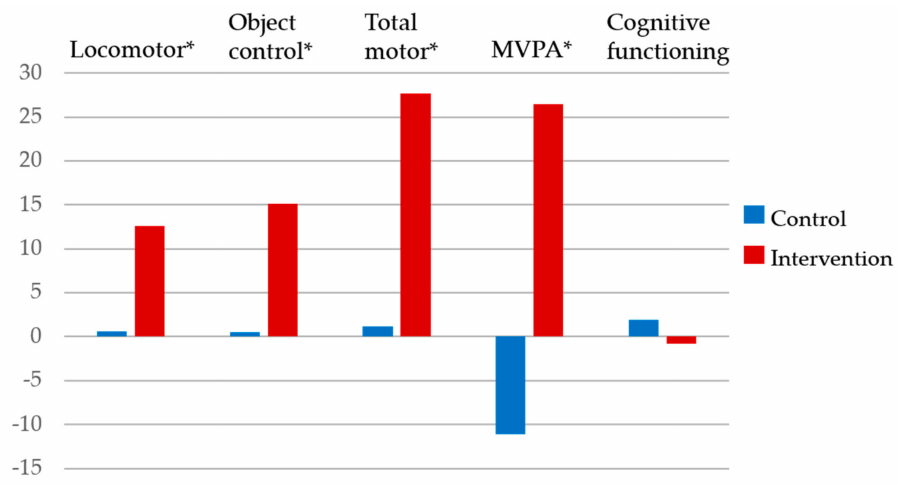
Figure 1. Gain scores in locomotor skills, object control skills, total motor skills, MVPA, and cognitive functioning. * indicates significant interaction e ff ects ( p ≤